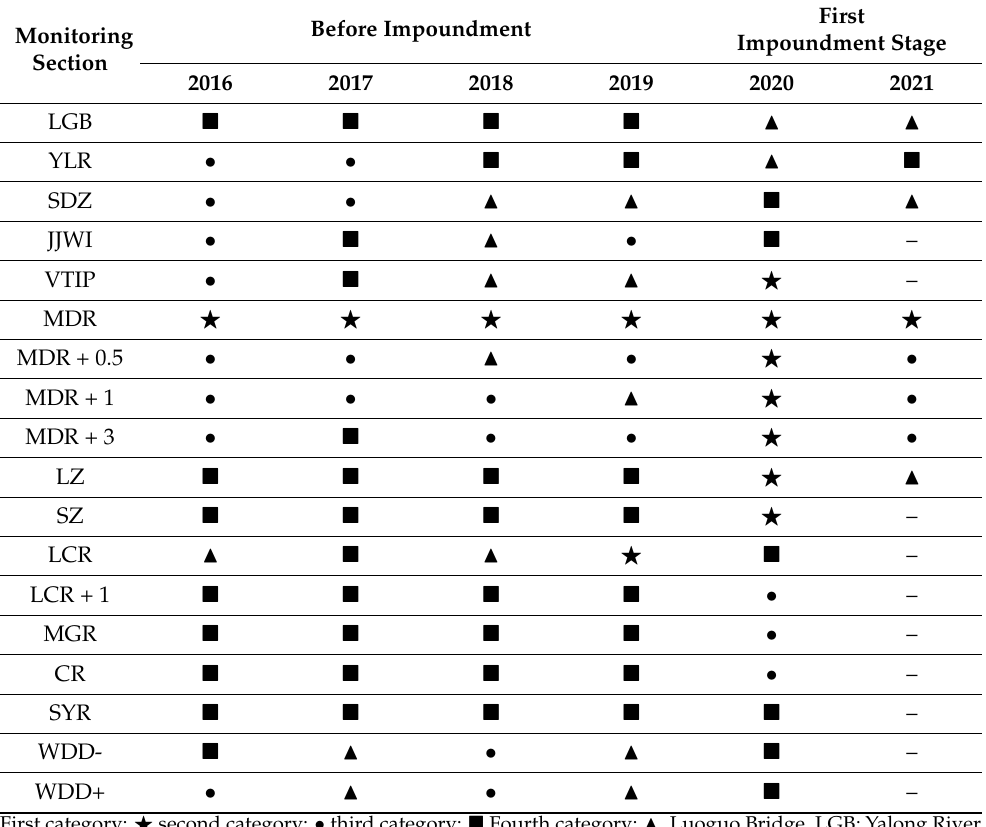
Table 3. Cluster analysis of each monitoring section in the Wudongde Reservoir area from 2016 to 2021. Monitoring